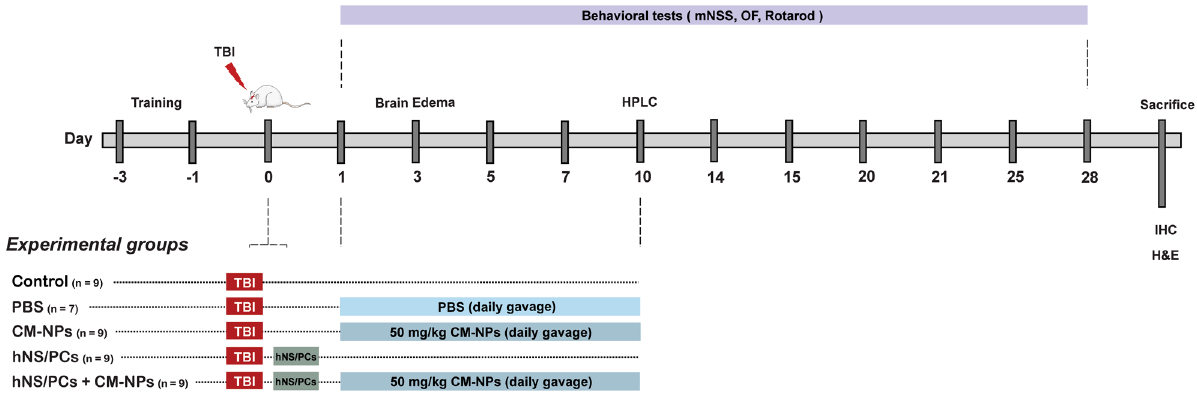
Figure 8. An overview of experimental design. Rats were trained 3 days before TBI to adapt to behavioral tests. Stem cell transplantation was performed 10 min after TBI in rats. The rotarod test was performed before TBI as well as on 5, 10, 15, 20, and 25 days, open field (OF) test was performed on 7, 14, 21, and 28 days, and mNSS test was performed Pre-TBI as well as 1, 7, 14, 21, and 28 days after TBI. In the CM-NPs and hNS/PCs + CM-NPs groups, 50 mg/kg CM-NPs were dissolved in PBS and gavaged daily. To evaluate brain water content, the brains were weighed on day 3 after TBI and incubated at 100 °C for 24 h and then were reweighed. In addition, HPLC analysis was performed to find out the optimal dose of CM-NPs on day 10 after TBI. After a 28-day treatment period, rats were sacrificed to assess lesion volume, gliosis, and TLR4/NF-κB inflammatory pathway by HE staining and IHC method,